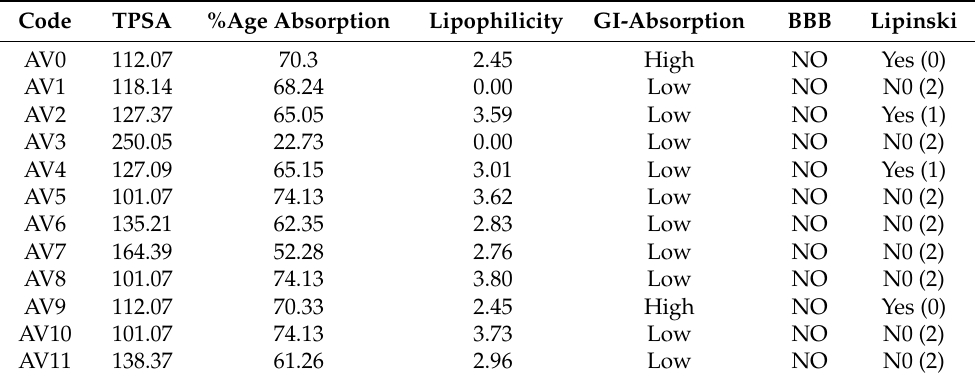
Table 1. Results of ADME studies of synthesized derivatives of 2-(N-((2 (cid:48) -(2H-tetrazole-5-yl)-[1,1 (cid:48)